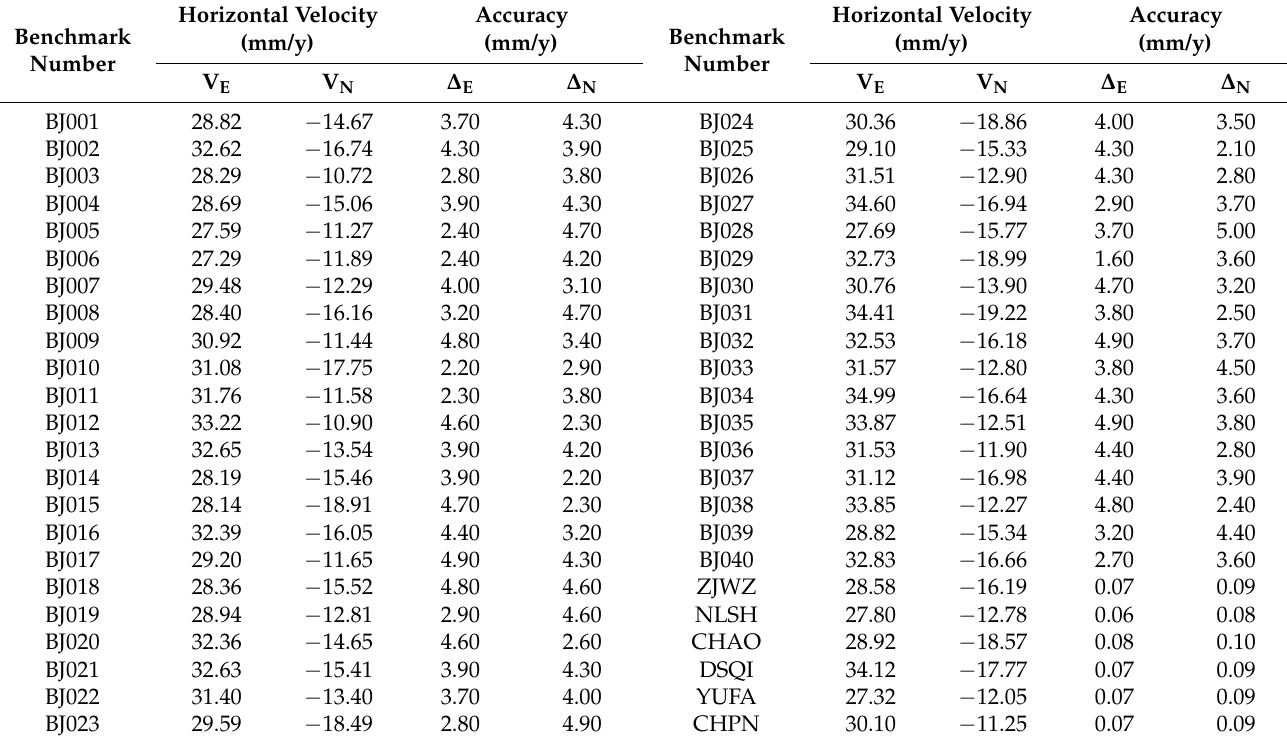
Table 3. The horizontal velocity and accuracy of GPS in 2017 under the ITRF2005 reference frame.